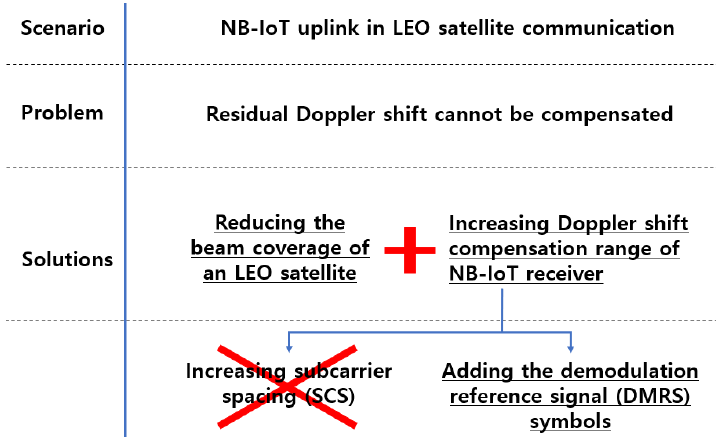
Figure 1. Problems and solutions for the NB-IoT uplink in